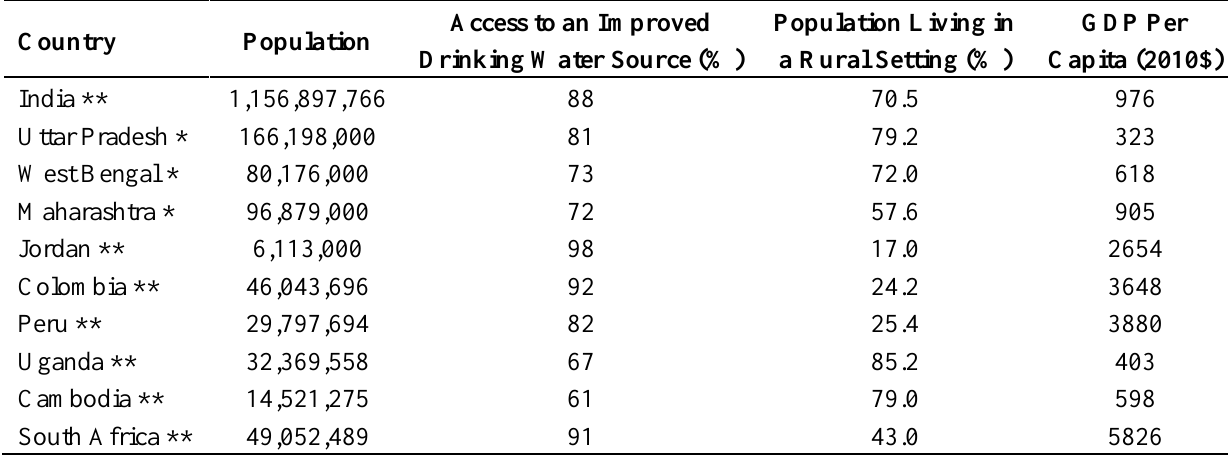
Table 5. Descriptive statistics for study